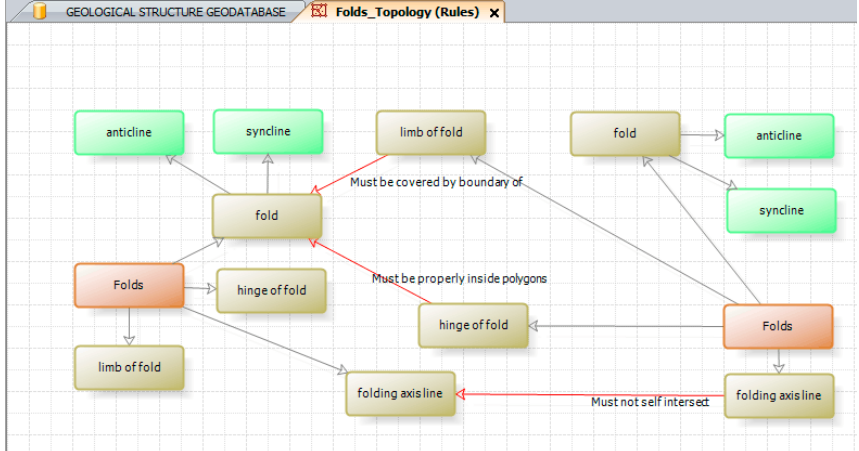
Figure 2. Geodatabase data model of the topology of fold elements.